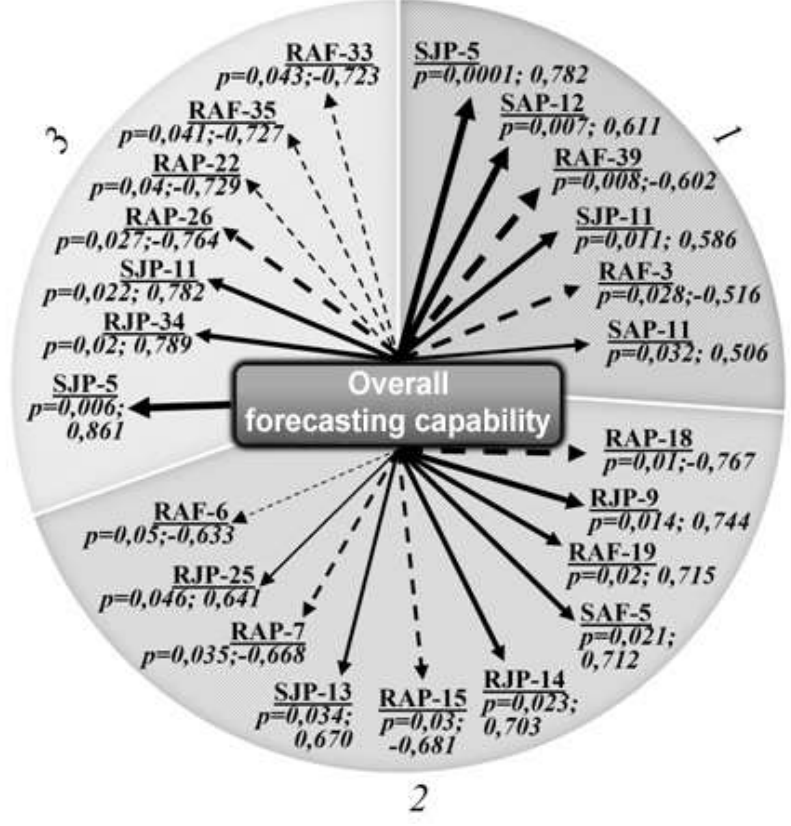
Figure 2. Overall forecasting capability in the subjective experience of mental states Legend: 1. Total data array; 2. Correlations in the group with low forecasting capability; 3. Correlations in the group with average forecasting